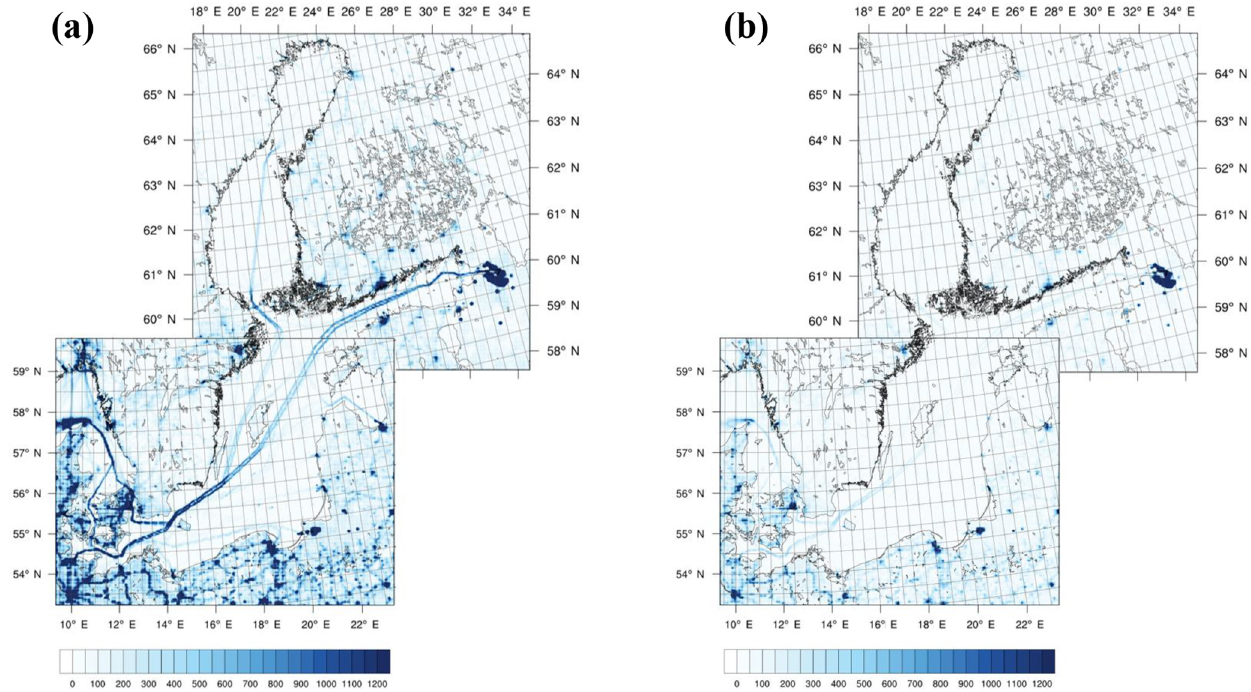
Figure 2. Annual total emissions of NO x (mg ( N ) m − 2 ) in the surface layer for the Baltic Sea region: (a) in 2012 and (b) in 2040 for the BAU scenario. Gridded emissions from the STEAM and SMOKE emission databases interpolated to a grid resolution of 4 × 4km 2 and transformed to a Lambert conformal projection for the two CMAQ high-resolution domains. Grid lines mark a lat–long grid with 0 . 5 × 0 . 5 ◦